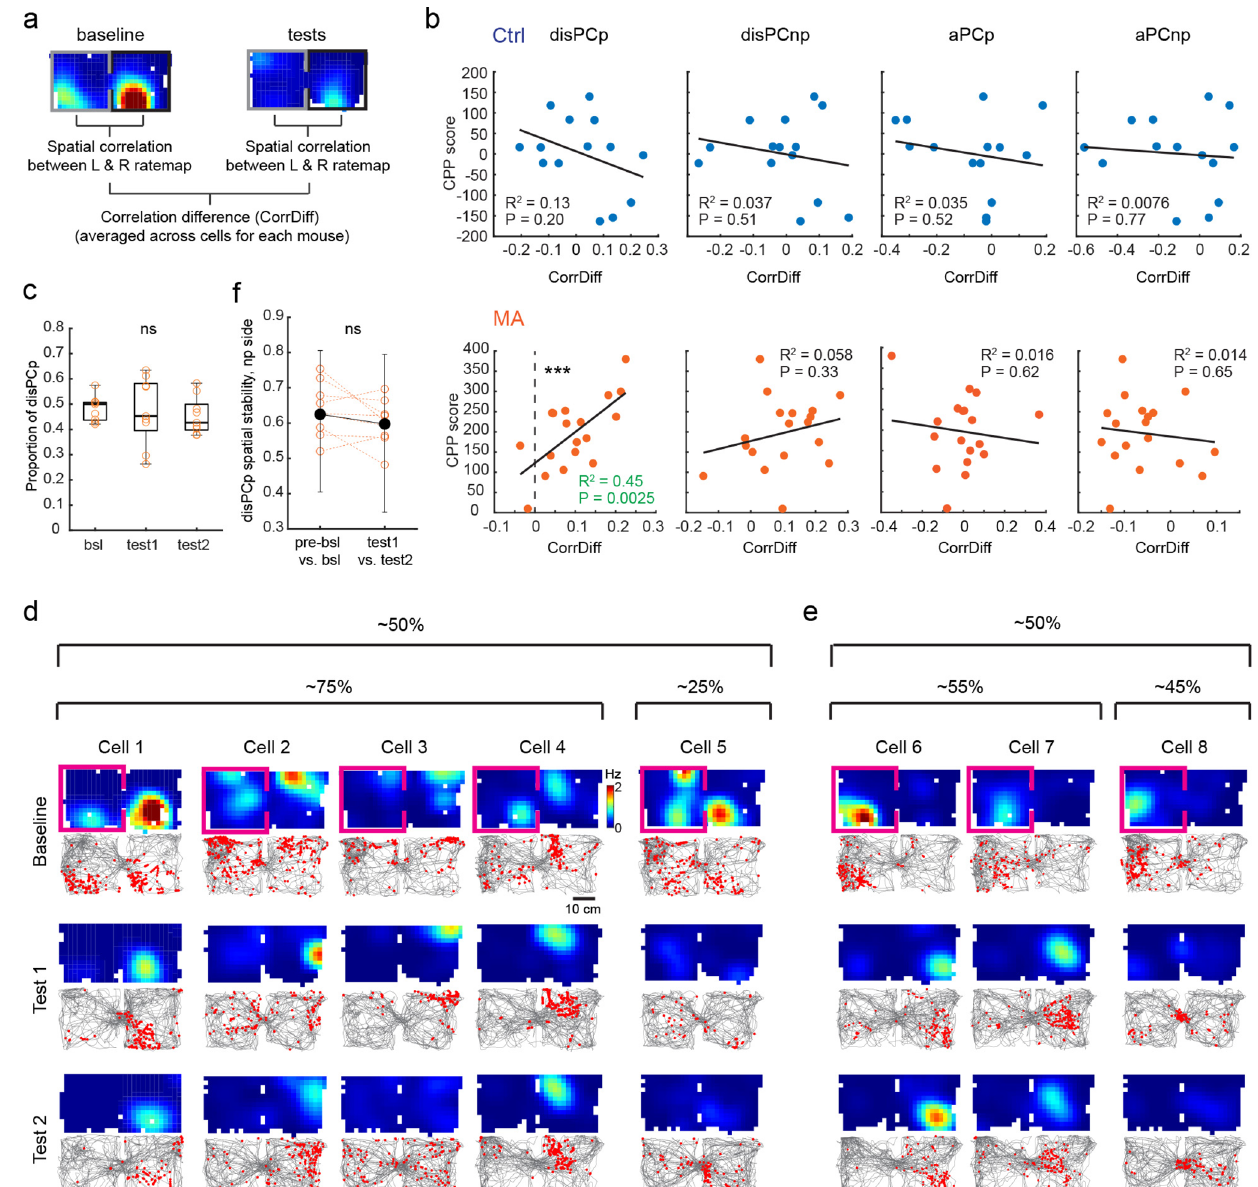
Fig. 3 | The activity of disPCp encodes the drug-context association. a Schematic for calculating inter-compartment correlation difference (CorrDiff) between baseline and test (test 1 or test 2) sessions for each neuron. b CorrDiff calculated using disPCp, but not other cell types, was signi fi cantly correlated with behavioral CPP scores in MA mice (orange, bottom). This correlation was not seen in Ctrl mice (blue, top). Each dot on the x-axis is a CorrDiff value for a mouse calculated using the designated cell types indicated on top. Each mouse has two CorrDiff values (baseline vs. test 1 and baseline vs. test 2).CorrDiff ofdisPCp inMA mice was also signi fi cantly higher than zero ( Z =3.55, p =3.86×10 − 4 , n =18 session pairs, two-tailed sign-rank test against zero). c The proportion of disPCp showing signi fi cant spatial tuning in the MA-paired context in MA mice (mean±SEM, bsl: 0.48±0.02;test1:0.47±0.04;test2:0.45±0.02;F(2,8)=0.25, p =0.78, n =9mice, repeated measures ANOVA). bsl: baseline. For box plot, the center indicates